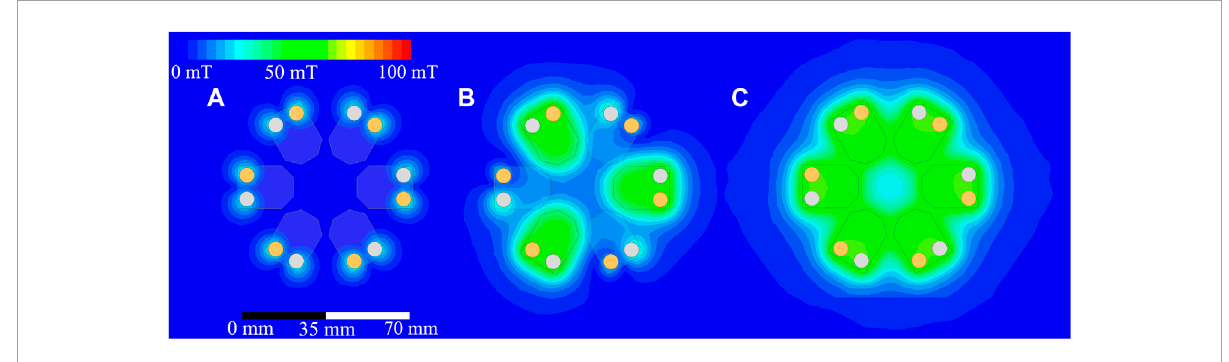
FIGURE 3 Depicted are three simulations completed in Ansys Maxwell of the EPM array from the top-down perspective. The AlNiCo magnet is orange, while the NdFeB magnet is white. (A) All EPMs are in the OFF configuration. (B) Three of the EPMs are ON, while the other three remain OFF. (C) All six EPMs are active, demonstrating fields of approximately 55 mT in the regions of interest, at the midpoint between the plates of the EPM and where the MRF will reside.